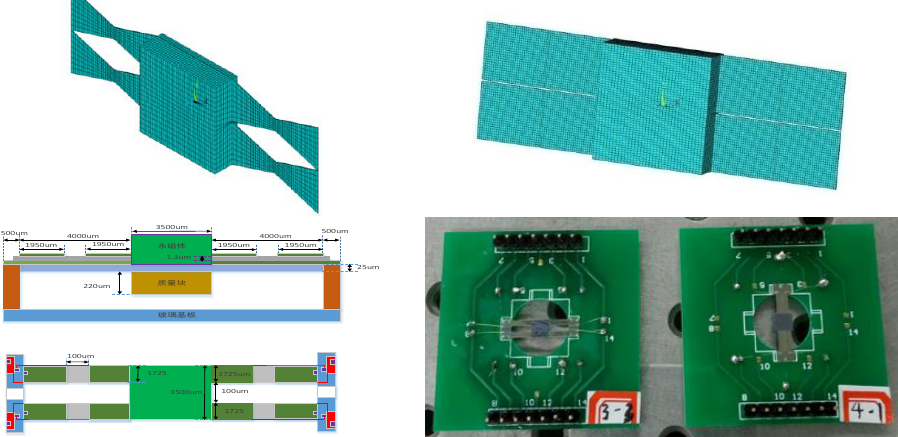
Figure 8. Double beams MEMS structures.